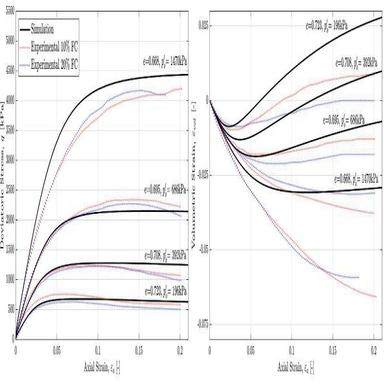
El Torito tailings sand. Simulations compared with experiments in drained triaxial tests based on Bravo.